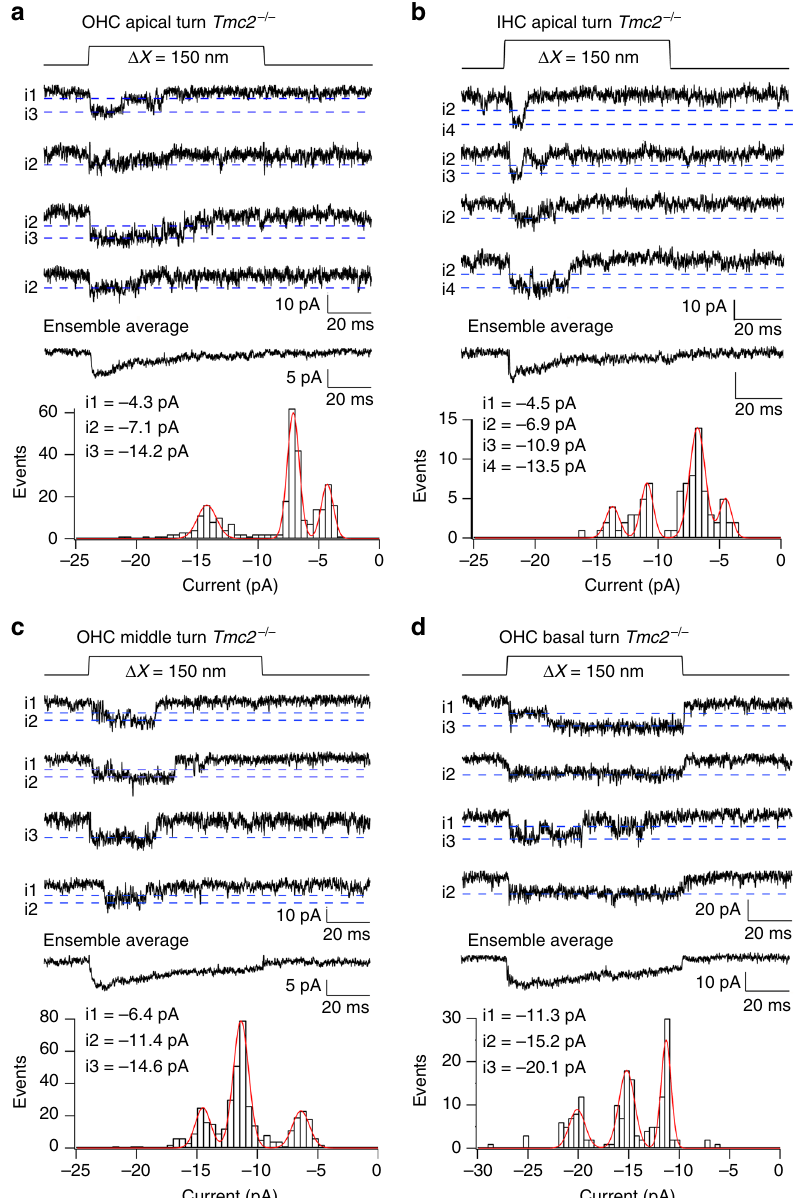
Fig. 4 MET single-channel distributions in OHCs and IHCs in Tmc2 − / − mice. a Four examples of single-channel current events in a P4 apical OHC, and ensemble average of 100 presentations of this bundle stimulus. Amplitude histogram of current levels, shown below fi tted with Gaussian of current levels i1, i2, and i3 denoted by blue dashed lines superimposed on single-channel traces. Current levels and standard deviation of Gaussian fi ts: − 4.3, 0.5 pA; − 7.1, 0.5 pA; − 14., 0.7 pA. b Examples of single-channel current events in a P6 apical IHC, and ensemble average of 100 presentations of this bundle stimulus. Current levels and standard deviation: − 4.5, 0.6 pA, − 6.9, 0.7 pA; − 10.9, 0.64 pA; − 13.5, 0.64 pA. c Four examples of single-channel current events in P3 middle turn OHC, and ensemble average of 100 stimulus presentations. Current levels and standard deviation: − 6.4, 0.7 pA; − 11.4, 0.6 pA; − 14.6, 0.6 pA. d Four examples of single-channel current events in P3 basal OHC and ensemble average of 100 presentations of this bundle stimulus at top. Current levels and standard deviation: ; − 11.3, 0.5 pA; − 15.2, 0.57 pA; − 20.1, 0.7 pA. Holding potential − 84 mV in all experiments. All measurements in low (0.04 mM) extracellular Ca 2